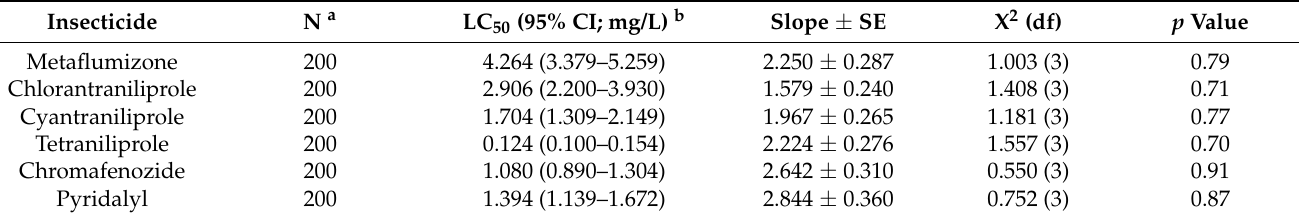
Table 3. Baseline susceptibility of S. litura to six insecticides in the susceptible strain Lab-S.